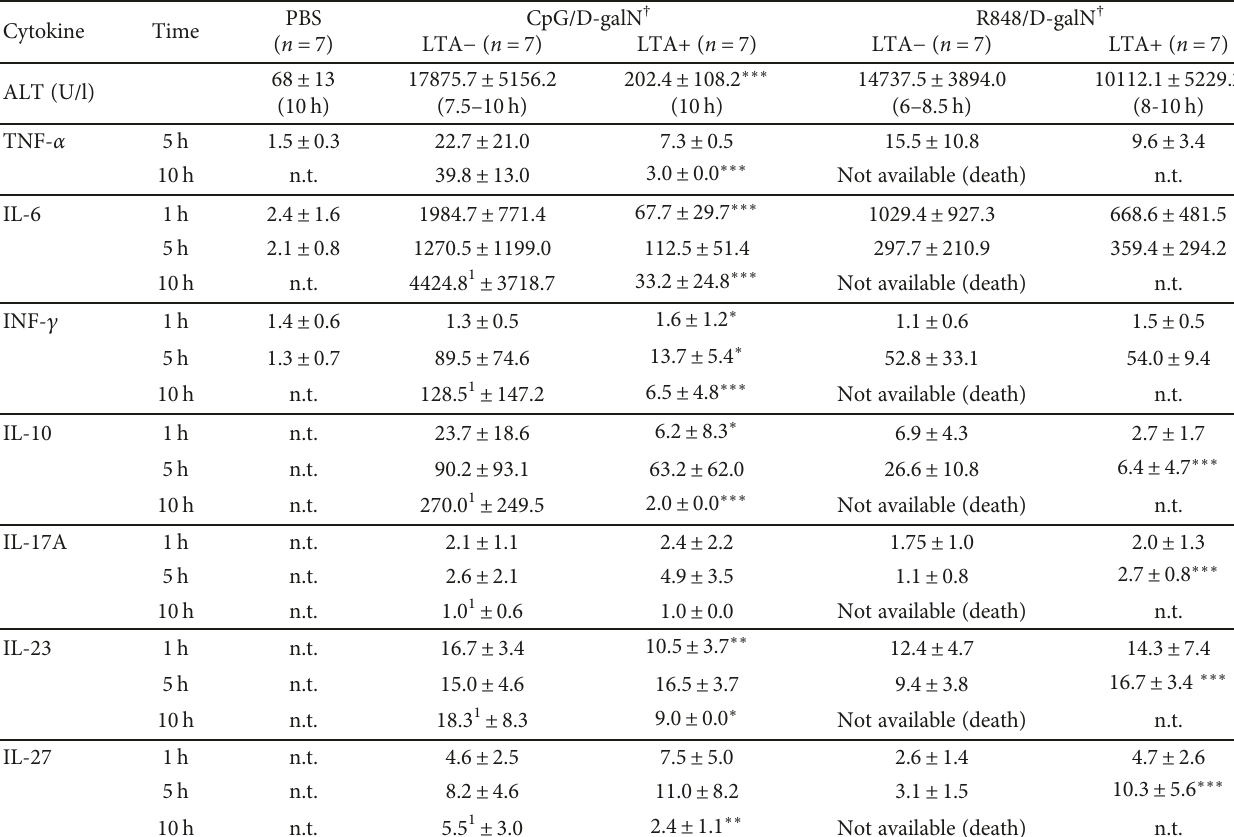
Table 3: Serum levels of cytokines (pg/ml) in a set of experiments with C57BL/6 mice. Mean ± SD is shown.